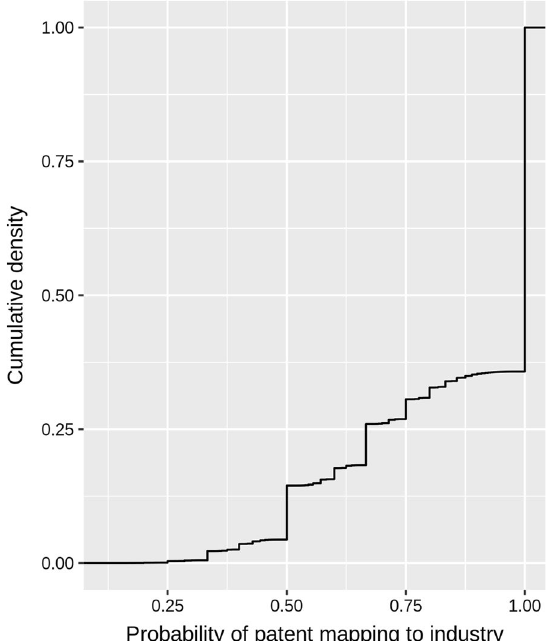
Fig. 6 Cumulative density of the patent-industry mapping probabilities. Notes : The graph shows the distribution of probabilities used to map patents to the Chemical, Computer/ICT, Electrical, Machinery, Medical, and Pharma industry. The data contain all patents used for our descriptive analysis. Specifically, it contains the filing years 2010–2015, the countries Canada, China, France, Germany, Japan, South Korea, Switzerland, the UK, and the